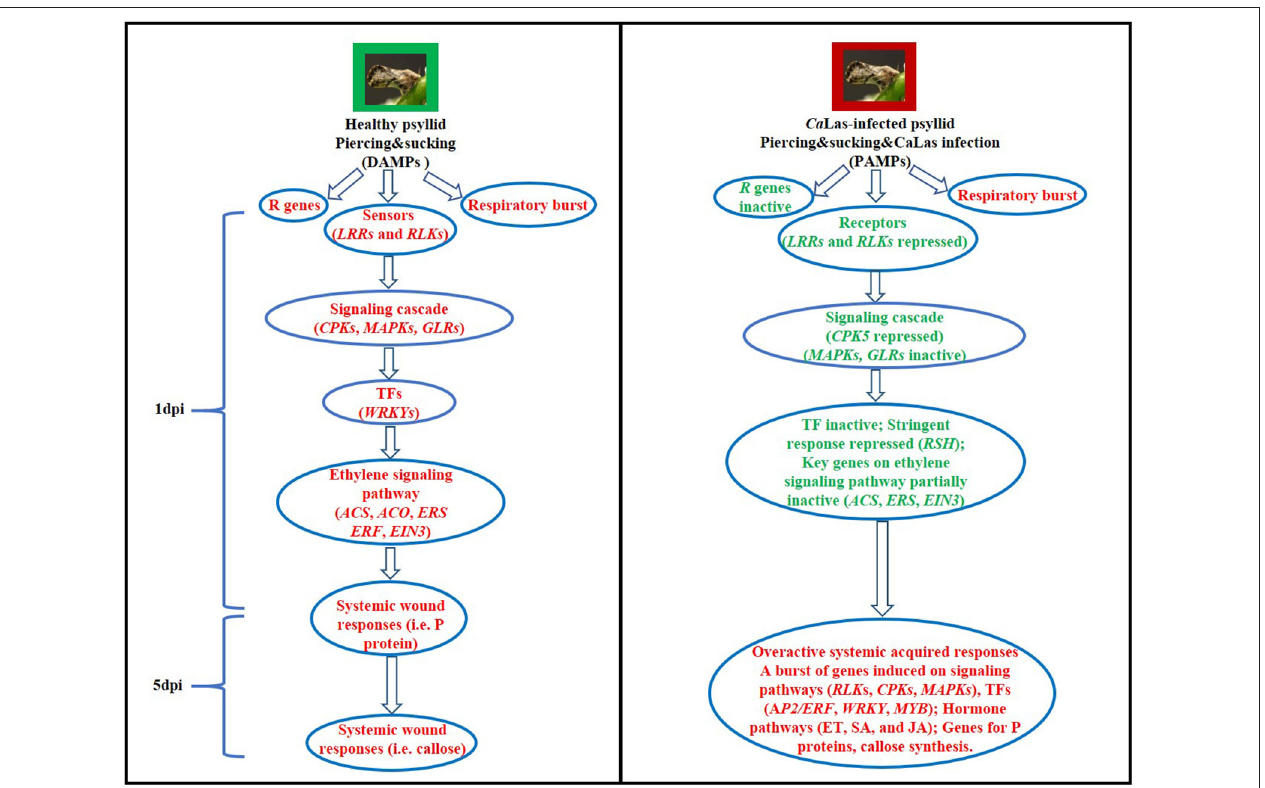
FIGURE 9 | Hypothetical models of the defense mechanisms in VAL under healthy and Ca Las-infected psyllid infestation at 1 and 5 dpi. Words in red represent activated steps and words in green represent repressed